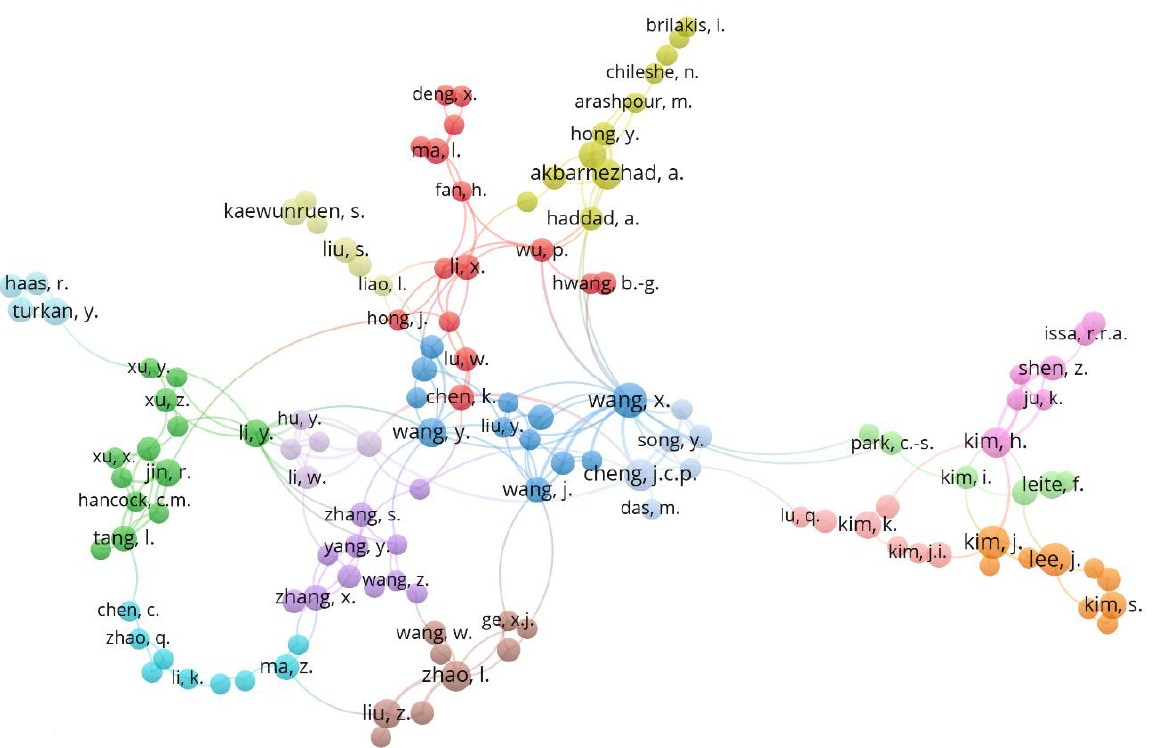
Figure 4. Visualization of co-authorship network for the only 130 connected co-authors based on the full counting techniques applied on the 770 articles of CCM.